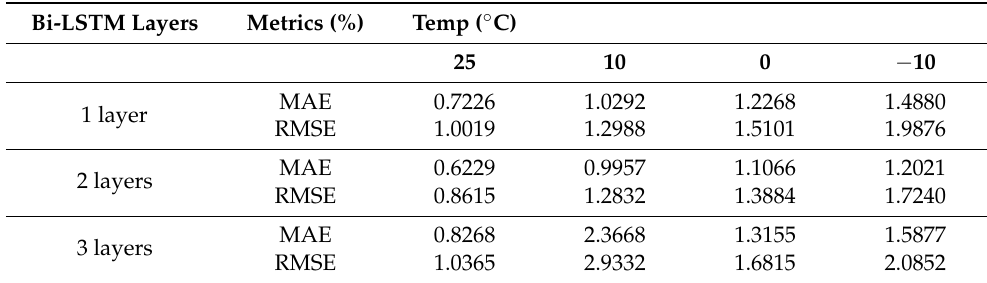
Table 2. Comparison of different number of bi-directional LSTM layers within the stacked and encoder–decoder blocks.